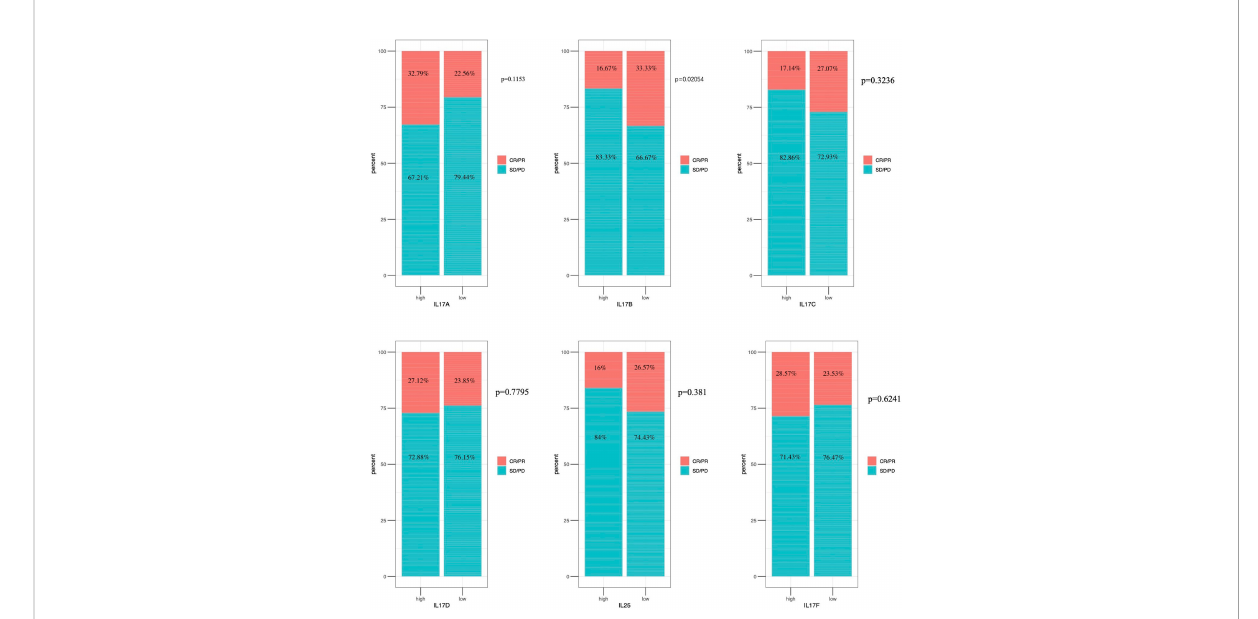
FIGURE 9 Immunotherapeutic response analysis. The differential expression of IL-17A – F between non-response and response in IMvigor